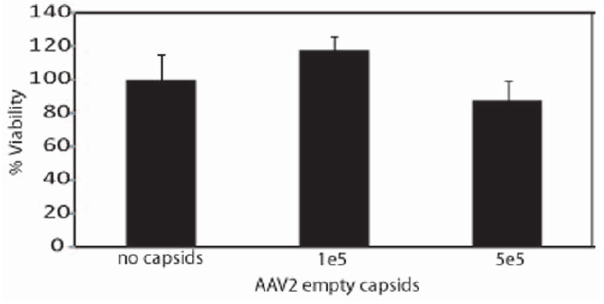
Figure 7. AAV empty capsid transduction of hESCs is non-toxic. AAV2 capsids were administered to hESCs at the indicated dose. Cell viability was determined after 24 h by dye exclusion. The average of at least 6 replicates is presented with the standard deviation. No significant difference (p-value . 0.1) was noted when treatment groups were compared to the no capsid control).